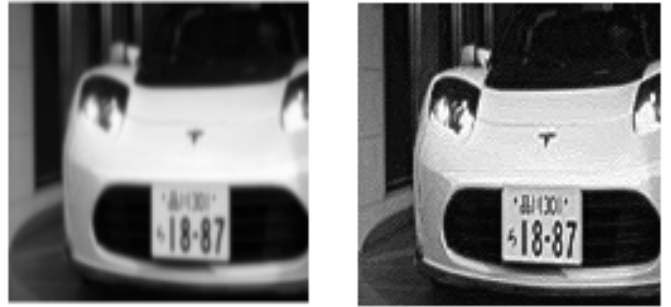
Figure 13. Result of deblurring on a comprehensive image set, in particular, on image 33_IM: ( Left ) input image; and ( Right ) output of the ICA neural system.